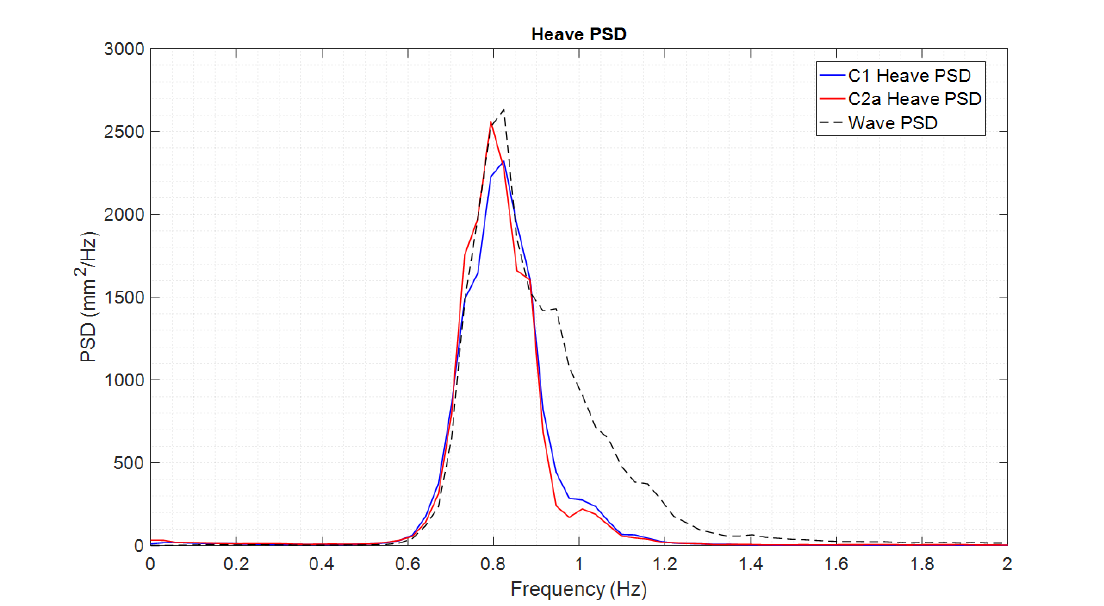
Figure 18. PSD of the heave motion and incoming